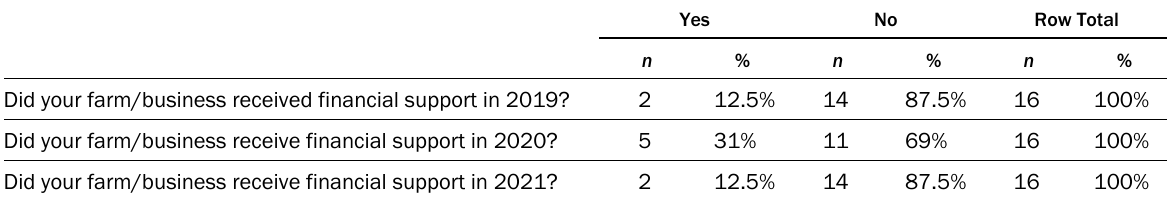
Table 4. Financial Support Status for the Past Three Years (2019 – 2021)